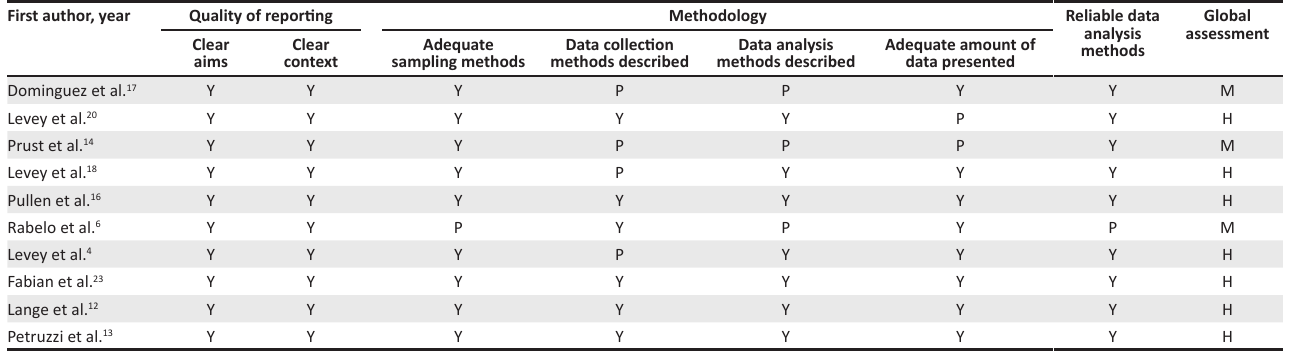
TABLE 3: Quality assessment for qualitative